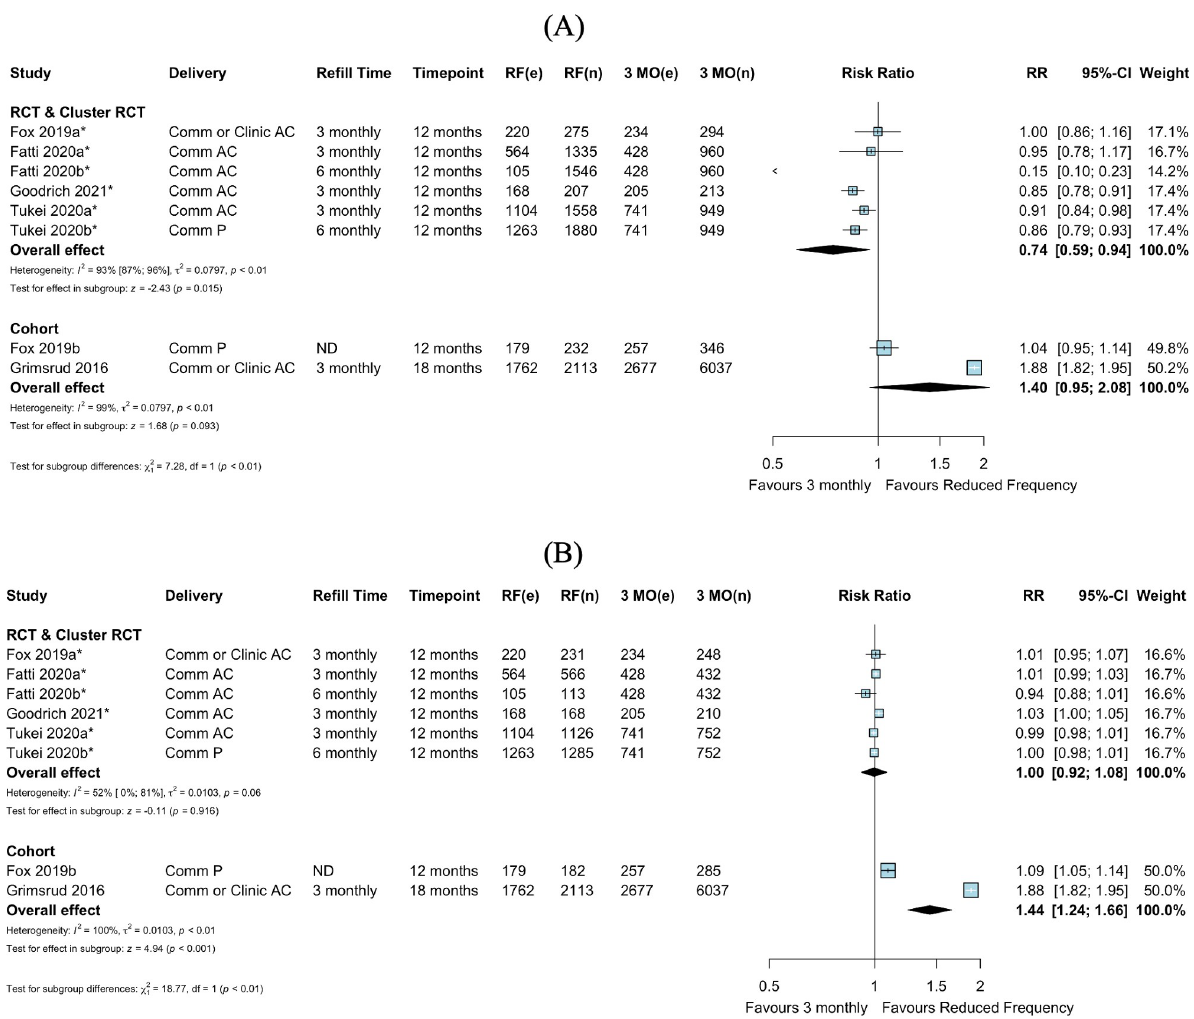
Fig 4. Viral suppression: Reduced frequency versus 3-monthly clinical consultations, by study design. (A) Among those randomized or enrolled. (B) Among those with viral load testing. Fox 2019a and Fox 2019b were separated into an RCT and cohort design, respectively, based on the analysis described by the authors, where randomization was not preserved in the intervention arm in Fox 2019b. � Cluster-adjusted RR. 3 MO, 3-monthly; AC, adherence club; Comm, community; e, number of events; n, number of participants; ND, not described; P, pharmacy; RCT, randomized controlled trial; RF, reduced frequency; RR, risk